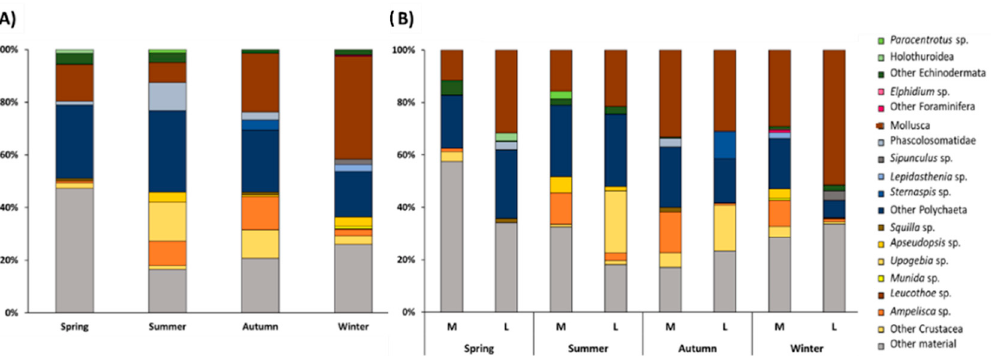
Figure 4. ( A ) Seasonal composition (%W) of the diet of Solea solea and ( B ) of the diet of medium- (M) and large-size (L) individuals captured from January to December 2019 in the Central